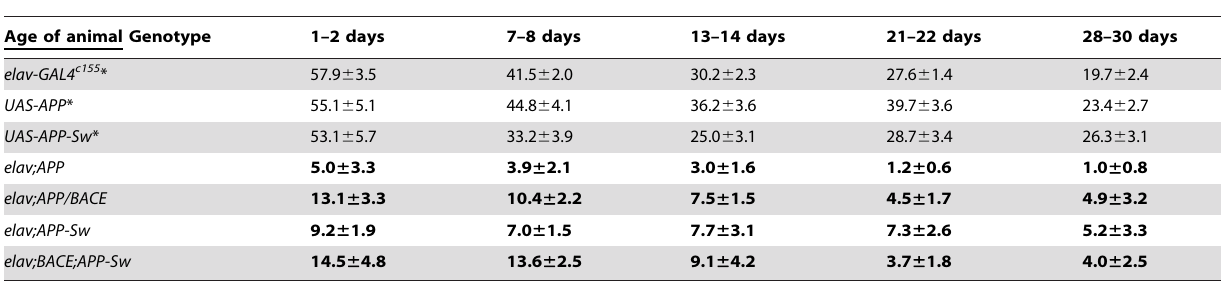
Table 2. Progressive loss of memory in APP -transgenic-flies.